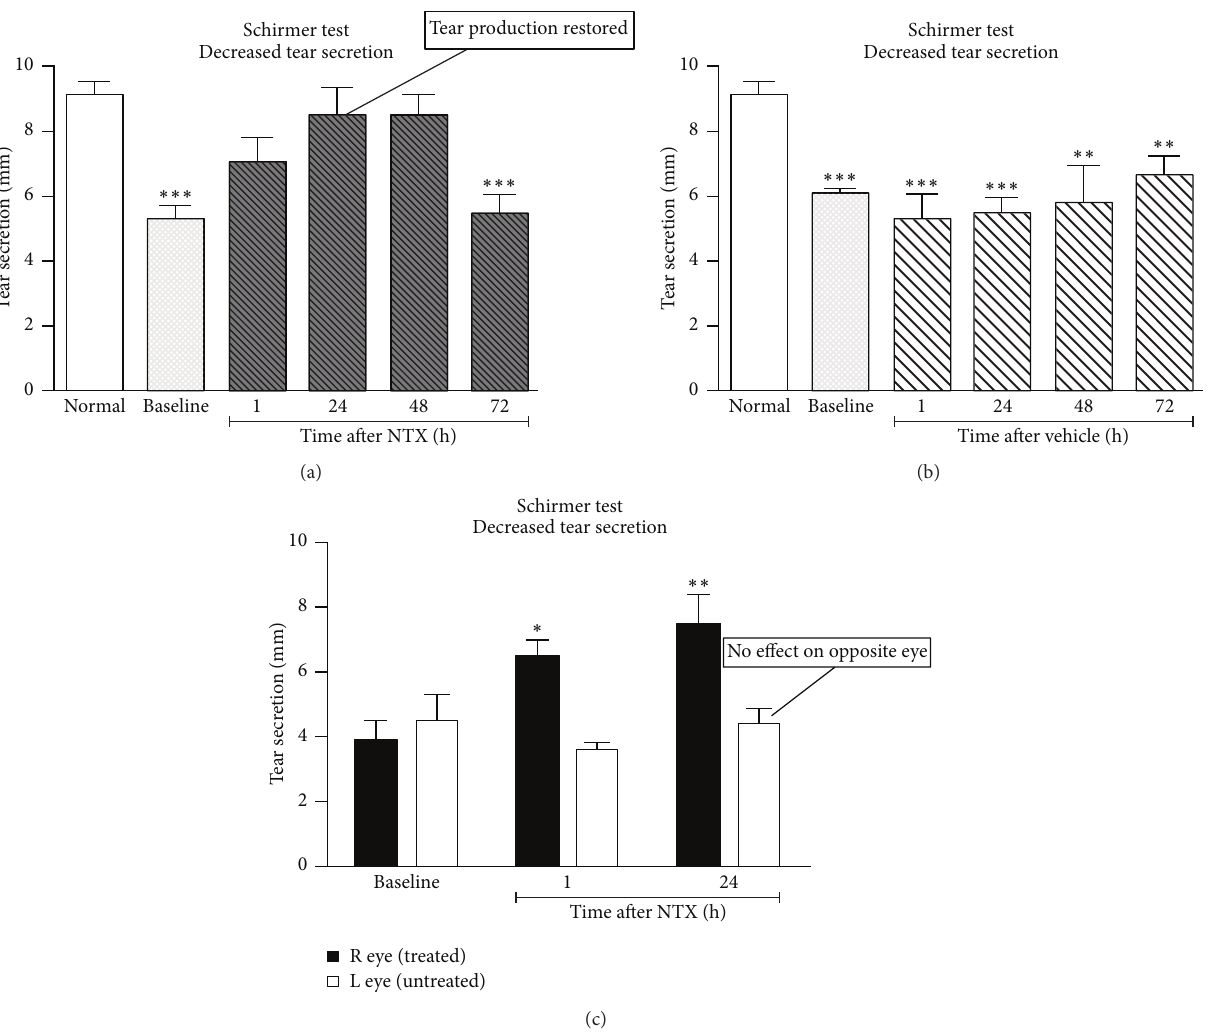
Figure 14: Impact of NTX treatment on tear secretion. (a) One drop of 10 −5 M NTX results in tear levels returning to normal for up to 48 hr. (b) Vehicle alone results in no improvement in tear secretion. Significantly different from normal rats at ∗∗ 𝑃 < 0.01 or ∗∗∗ 𝑃 < 0.001 . (c) Right and left eyes compared after one drop of 10 −5 M NTX in the right eye. Significantly different from left eye at ∗ 𝑃 < 0.05 and ∗∗ 𝑃 < 0.01 . Values represent means ± SEM (derived from Zagon et al., 2012